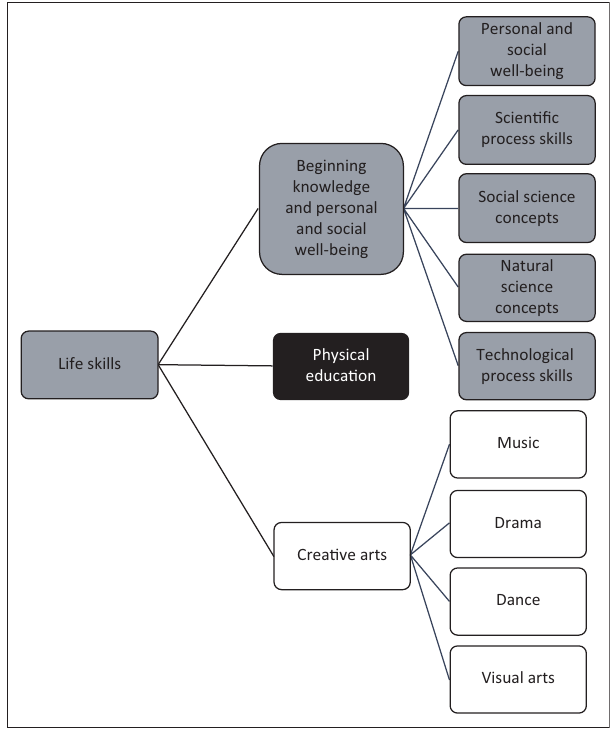
FIGURE 1: Life Skills in the Foundation